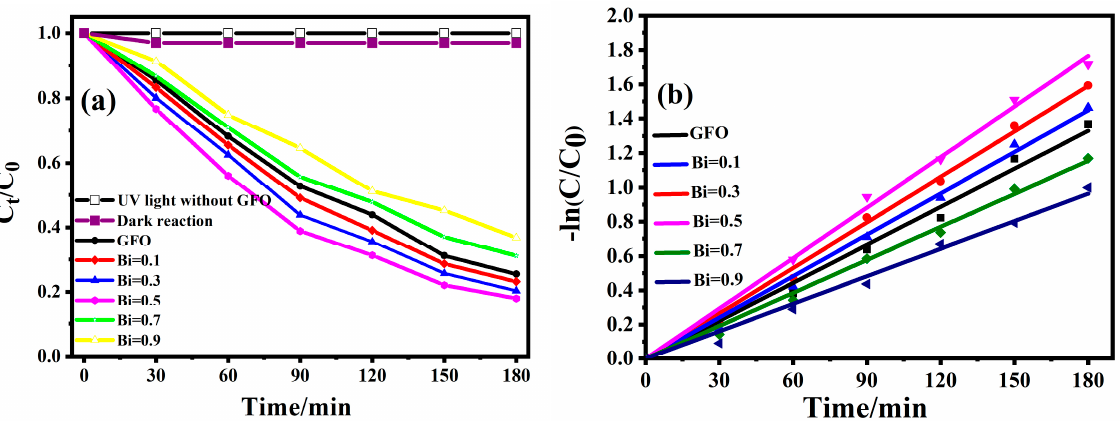
Figure 6. ( a ) Photocatalytic degradation efficiencies of MB using Gd 1 − x Bi x FeO 3 as a catalyst; ( b ) pseudo-first-order kinetics fitting data for the photodegradation of MB over Gd 1 − x Bi x FeO 3 samples.